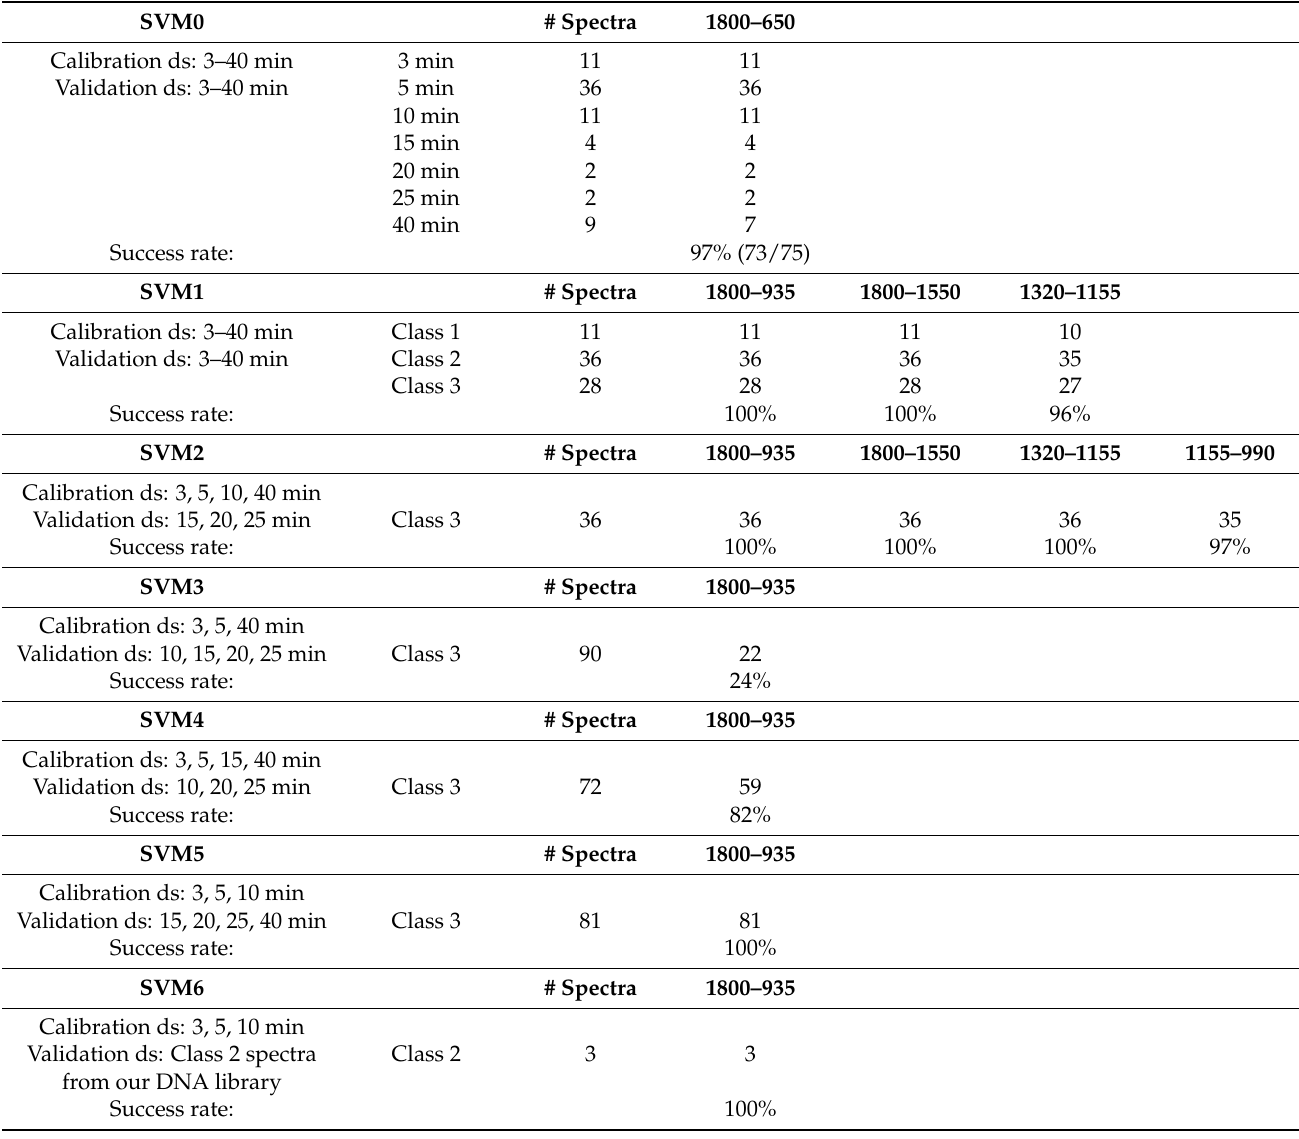
Table 1. Summary of SVM models and obtained validation results. The abbreviation used for datasets is ds. The SVM0 model was trained to classify spectra according to seven distinct desiccation times (seven classes), from 3 to 40 min, while SVM1-SVM6 models were trained on the spectra categorized with respect to the level of B form: class 1 (40%, 3 min film), are indicated in the columns above the number of spectra obtained per class. Label # spectra represents the size of the validation ds (the total number of spectra per each class included in the validation dataset), while the success rate is the ratio of correctly classified spectra and the size of the validation